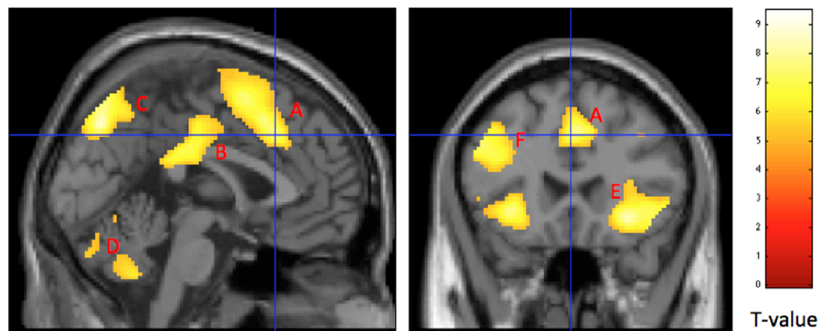
Figure 4. Main areas of interest representing cerebral activation when contrasting incongruent . congruent stimuli for FM patients (n=23) and HC (n=28) together. Results are reported at p , 0.05, FWE corrected for multiple comparisons. A: dorsal anterior cingulate cortex (dACC), B: posterior cingulate cortex (PCC), C: precuneus, D: cerebellum, E: Insula (bilateral) and F: dorsolateral prefrontal cortex (dlPFC).